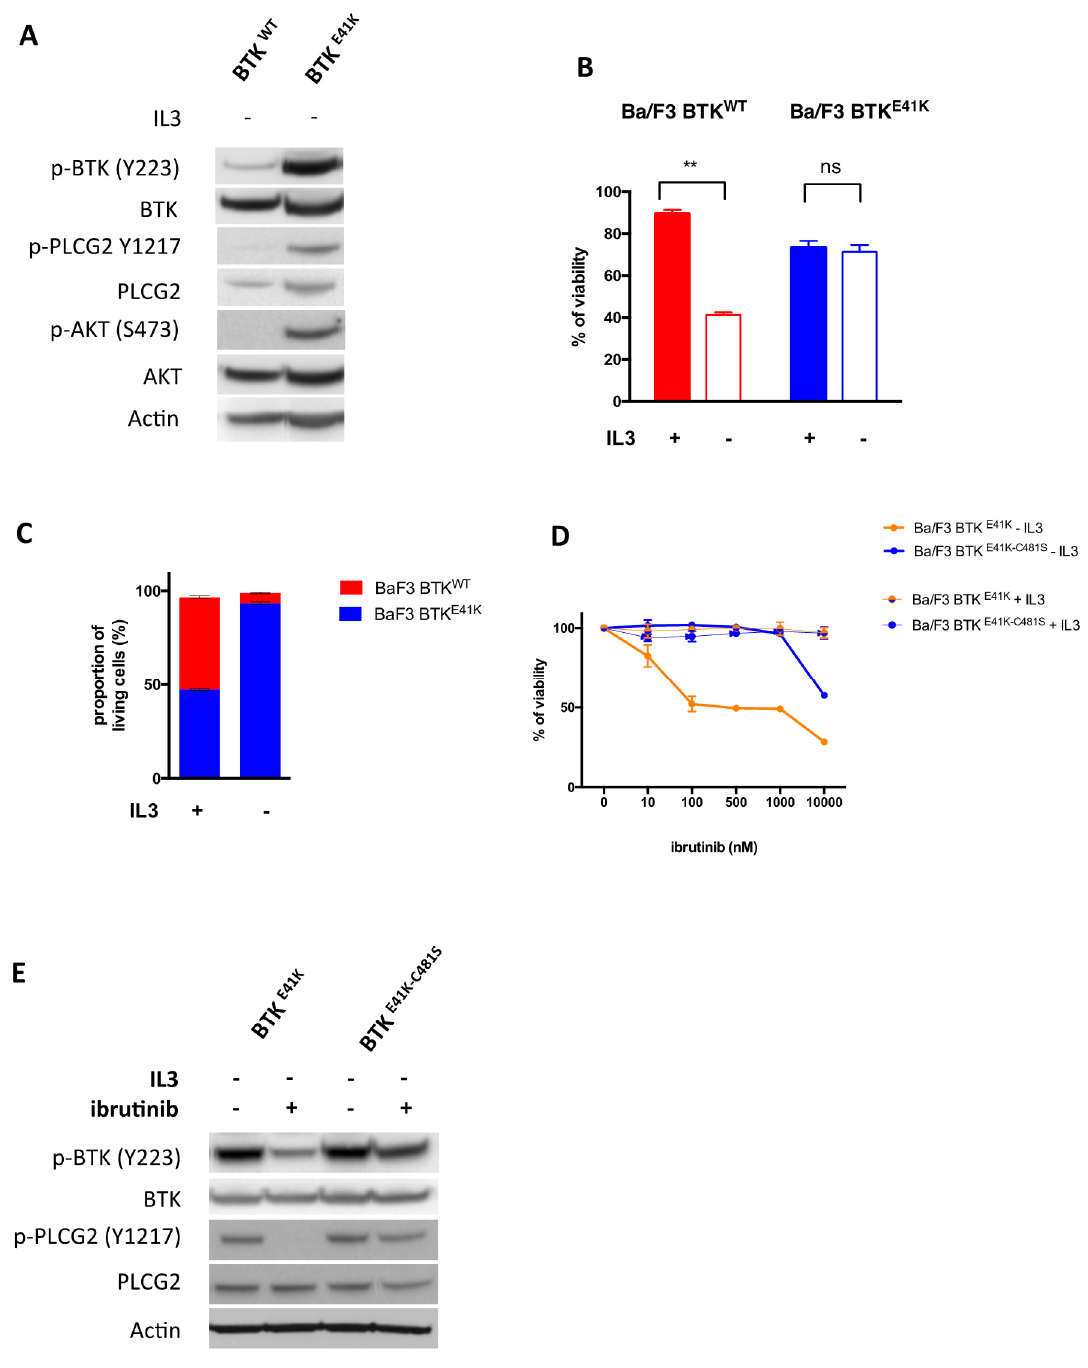
Figure 1. Engineering of a cell line to establish a collateral sensitivity screen. ( A ) Immunoblotting of Ba / F3 cells overexpressing either BTK WT or BTK E41K after a 4 h interleukin 3 (IL3) deprivation. ( B ) Proliferation assay of Ba / F3 cells overexpressing either BTK WT or BTK E41K with or without IL3. ( C ) Competitive assay of Ba / F3 cells overexpressing BTK WT (mCherry positive) or BTK E41K (GFP positive). The proportion of each cell type was measured after a 3 days culture with or without IL3. ( D ) Relative survival of ibrutinib treated Ba / F3 cells (as compared to vehicle treated cells) overexpressing either BTK E41K-C481S or BTK E41K in the presence (thin lines) or in the absence of IL3 (thick lines). ( E ) Immunoblotting of Ba / F3 cells overexpressing either BTK E41K or BTK E41K-C481S after a 4 h IL3 deprivation with or without 100 nM ibrutinib. ** p < 0.01; NS: Non significant. A t-test was used to assess the statistical significance of the